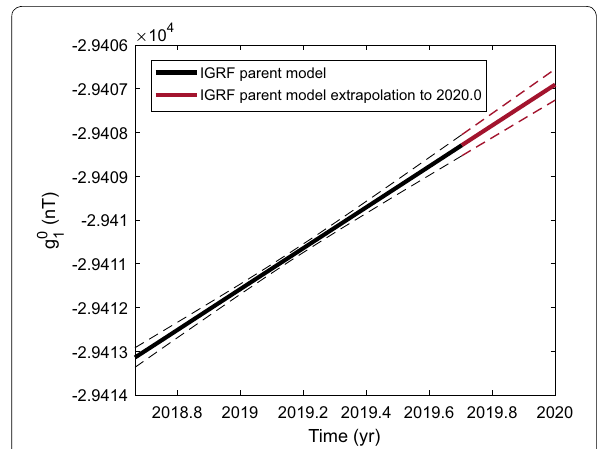
Fig. 10 Extrapolation of the IGRF parent model to 2020.0 for g 0